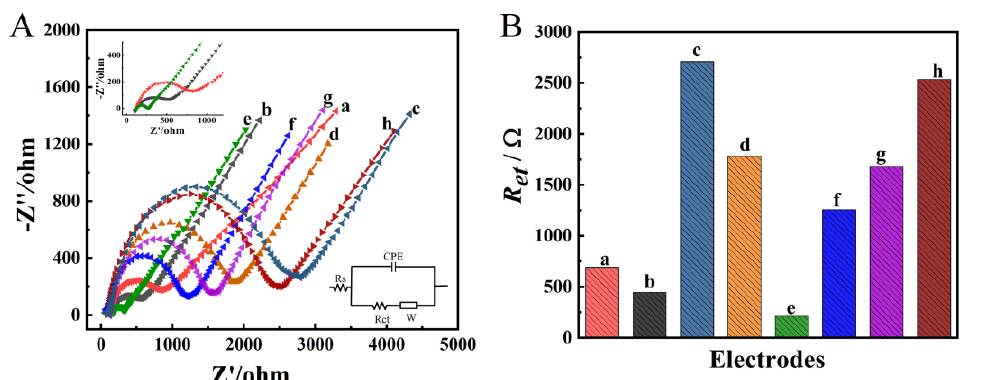
Figure 7. EIS of different modified GCEs in 0.1 M KCl solution containing the 5 mM [Fe(CN) 63-/4- ](1:1) ( A ) and the Ret values for different modified GCEs ( B ). a : bare GCE, b: